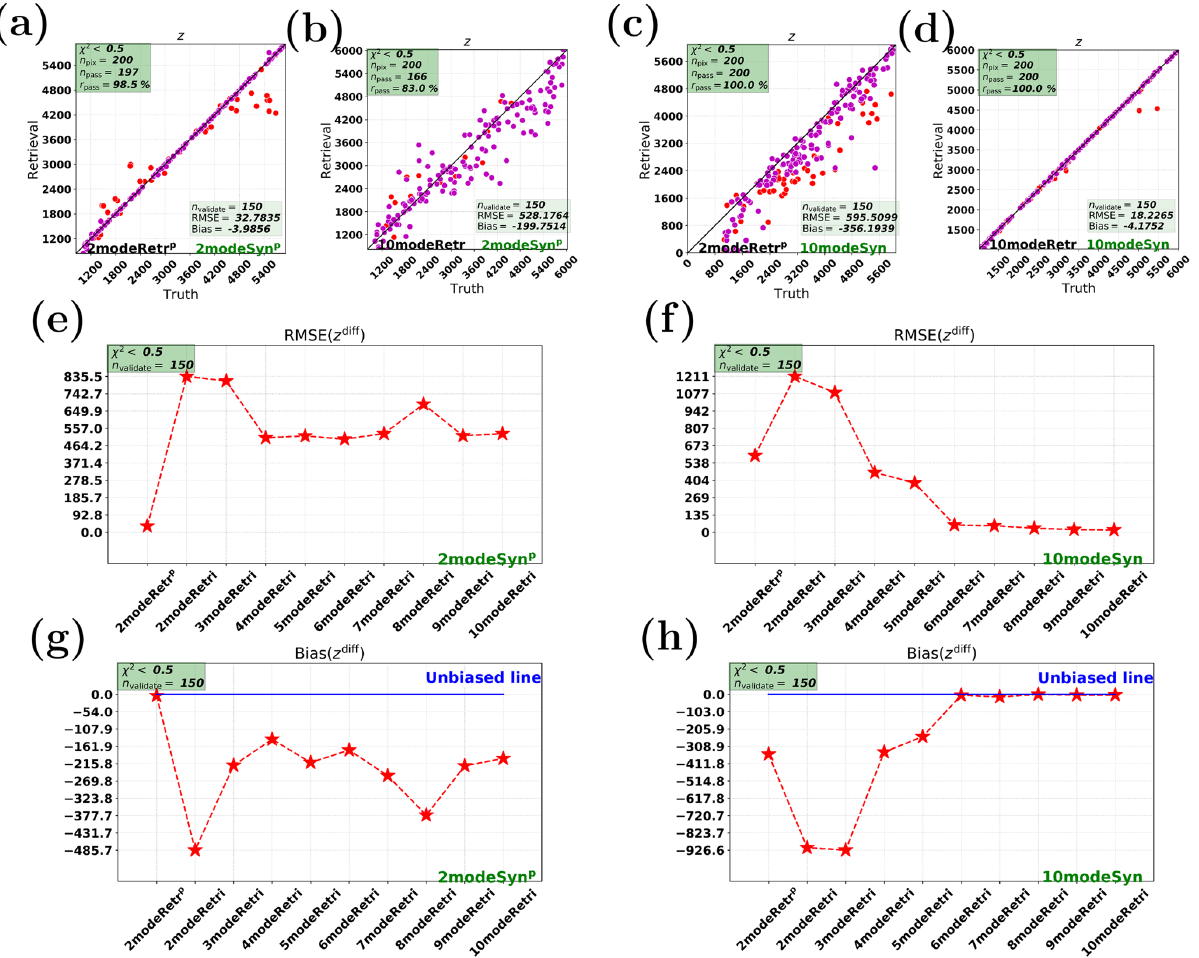
Figure 11. Synthetic retrievals for the central height ( z ) of the aerosol layer. Panels (a, b, e, g) and (c, d, f, h) show cases on 2modeSyn p and 10modeSyn, respectively.